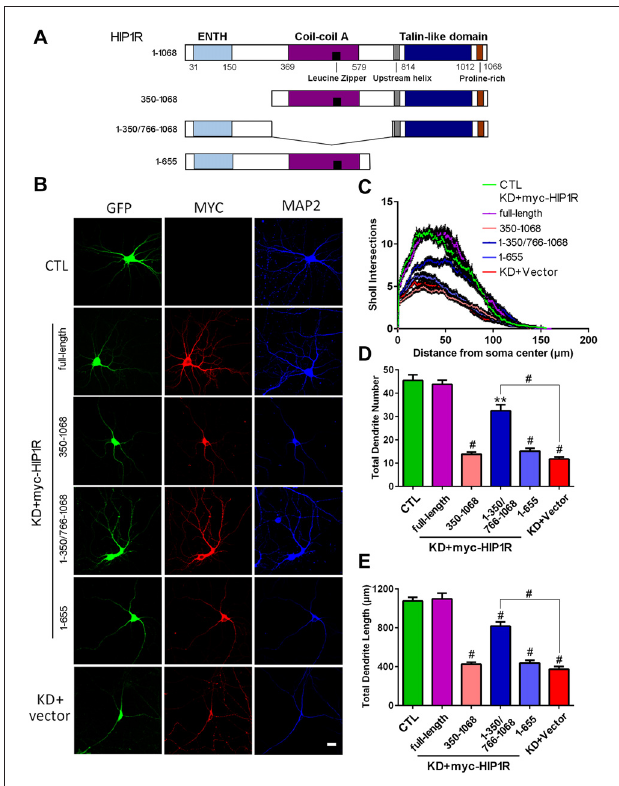
FIGURE 7 | Transfection of mouse HIP1R rescues the dendrite growth defects in HIP1R-knockeddown neurons. (A) A schematic illustration showing mouse full-length and several truncated forms of HIP1R cDNA in the myc-tagged expressing vector. (B) Cultured hippocampal neurons at DIV6 were co-transfected with HIP1R-shRNA for knocking down endogenous HIP1R expression, and full-length or truncated HIP1R vectors for re-expressing exogenous cognates. Transfected neurons were immunostained with myc and MAP2 antibodies at DIV12. GFP-expressing and positively myc stained neurons were used for morphological analysis. (C) ANOVA analysis with repeated measures of Sholl analysis showed that full-length HIP1R re-expression fully rescued the complexity impairment in HIP1R KD neurons.